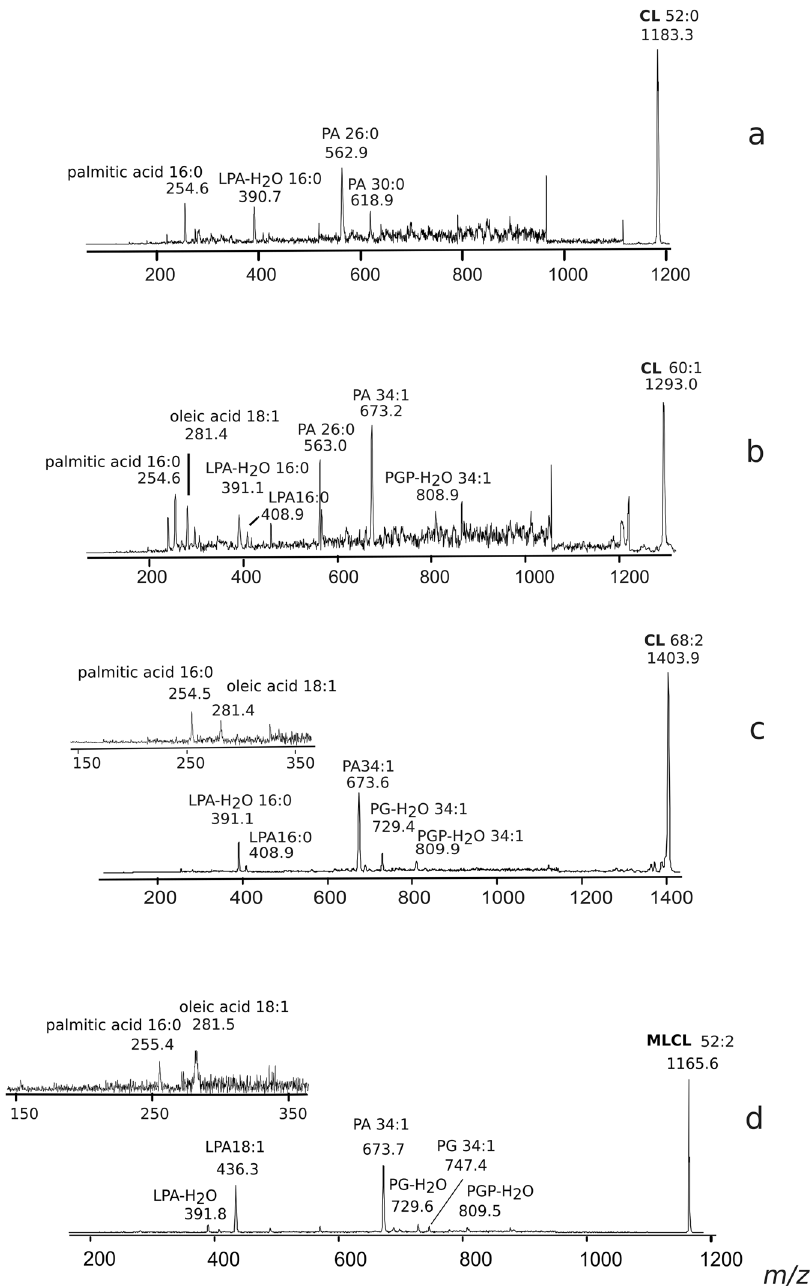
Figure 5. Fragmentation patterns of monolysocardiolipin and cardiolipins. PSD analysis of the peaks at m/z 1183.3 ( a ) 1293.0 ( b ), 1403.9 ( c ) and 1165.6 ( d ). ( a ) PSD analysis of the peak at m/z 1183.3: ion fragments correspond to PA ( m/z 618.9), PA ( m/z 562.9), LPA-H 2 O ( m/z 390.7) and the fatty acid 16:0 ( m/z 254.6). ( b ) PSD analysis of the peak at m/z 1293.0: ion fragments correspond to PGP-H 2 O ( m/z 808.9), PA ( m/z 673.2), PA ( m/z 563.0), LPA ( m/z 408.9), LPA-H 2 O ( m/z 391.1) and fatty acids 18:1 ( m/z 281.4) and 16:0 ( m/z 254.6). ( c ) PSD analysis of the peak at m/z 1403.9: ion fragments correspond to PGP-H 2 O ( m/z 809.9), PG-H 2 O ( m/z 729.4), PA ( m/z 673.6), LPA ( m/z 408.9), LPA-H 2 O ( m/z 391.1). In the x-axis enlargement of m/z range 150– 350, two peaks are referable to the fatty acids 18:1 ( m/z 281.4) and 16:0 ( m/z 254.5). ( d ) PSD analysis of the peak at m/z 1165.6: ion fragments correspond to PGP-H 2 O ( m/z 809.5), PG ( m/z 747.4), PGP-H 2 O ( m/z 729.6), PA ( m/z 673.7), LPA ( m/z 436.3), LPA-H 2 O ( m/z 391.8). In the x-axis enlargement of m/z range 150–350, two peaks are referable to fatty acids 18:1 ( m/z 281.5) and 16:0 ( m/z